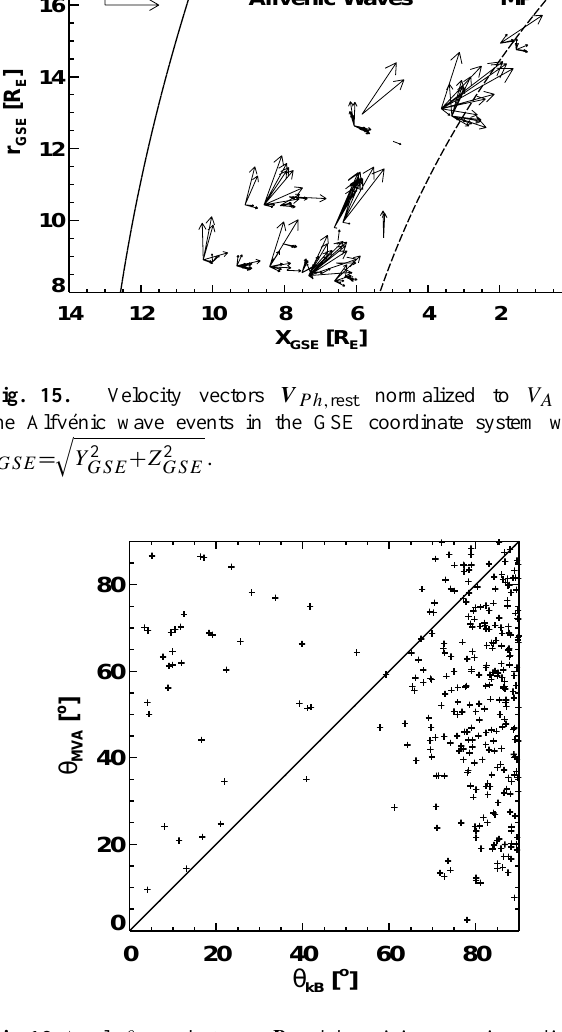
Fig. 16. Angle θ MVA between B and the minimum variance direc- tion e min compared to the propagation angle θ kB , determined by the wave